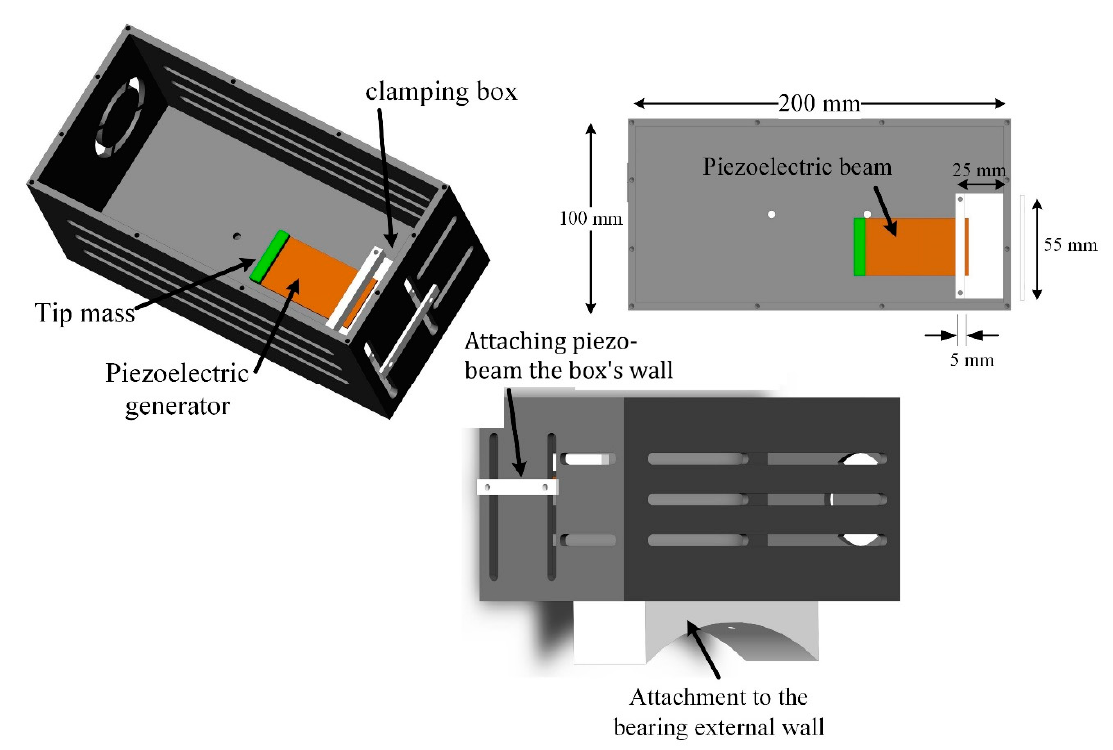
Figure 3. The energy harvesting box demonstrates the bearing attachment point and piezoelectric beam with the clamping box.